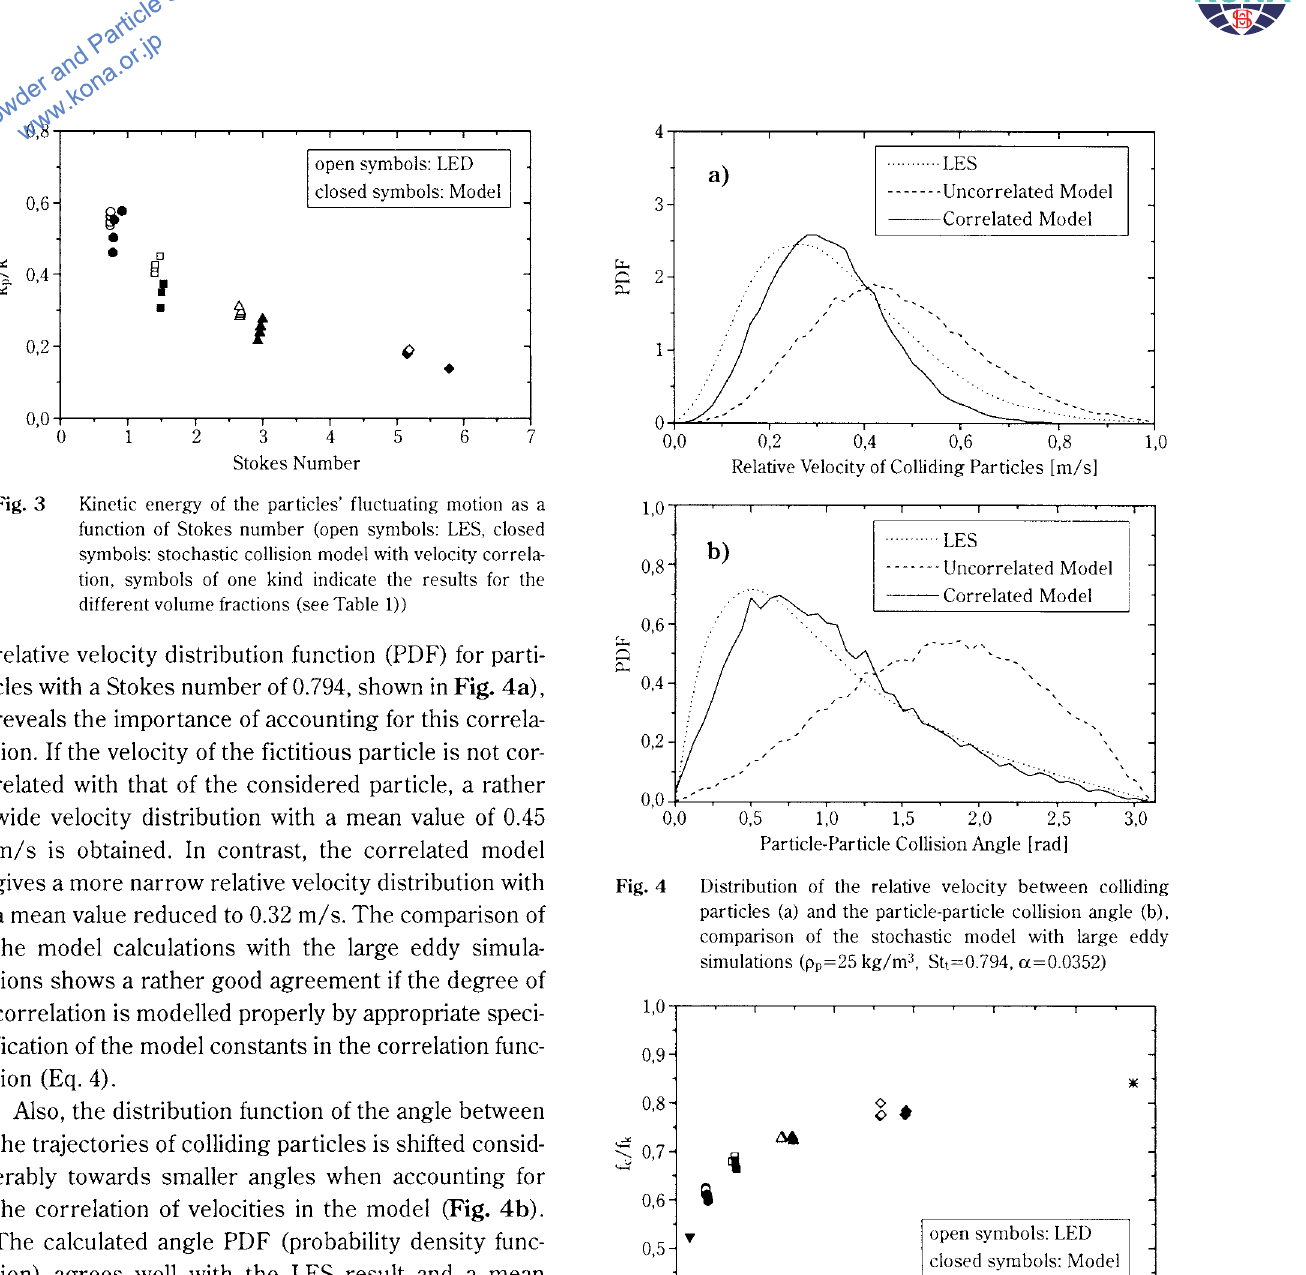
Dependence of the ratio of simulated collision frequency to the collision frequency obtained from the kinetic theory limit on the particle Stokes number (open symbols: LES. closed symbols: stochastic collision model with velocity correlation, symbols of one kind indicate the results for the different volume fractions) The predicted increase of the frequency ratio with Stokes number is in very good agreement with the LES